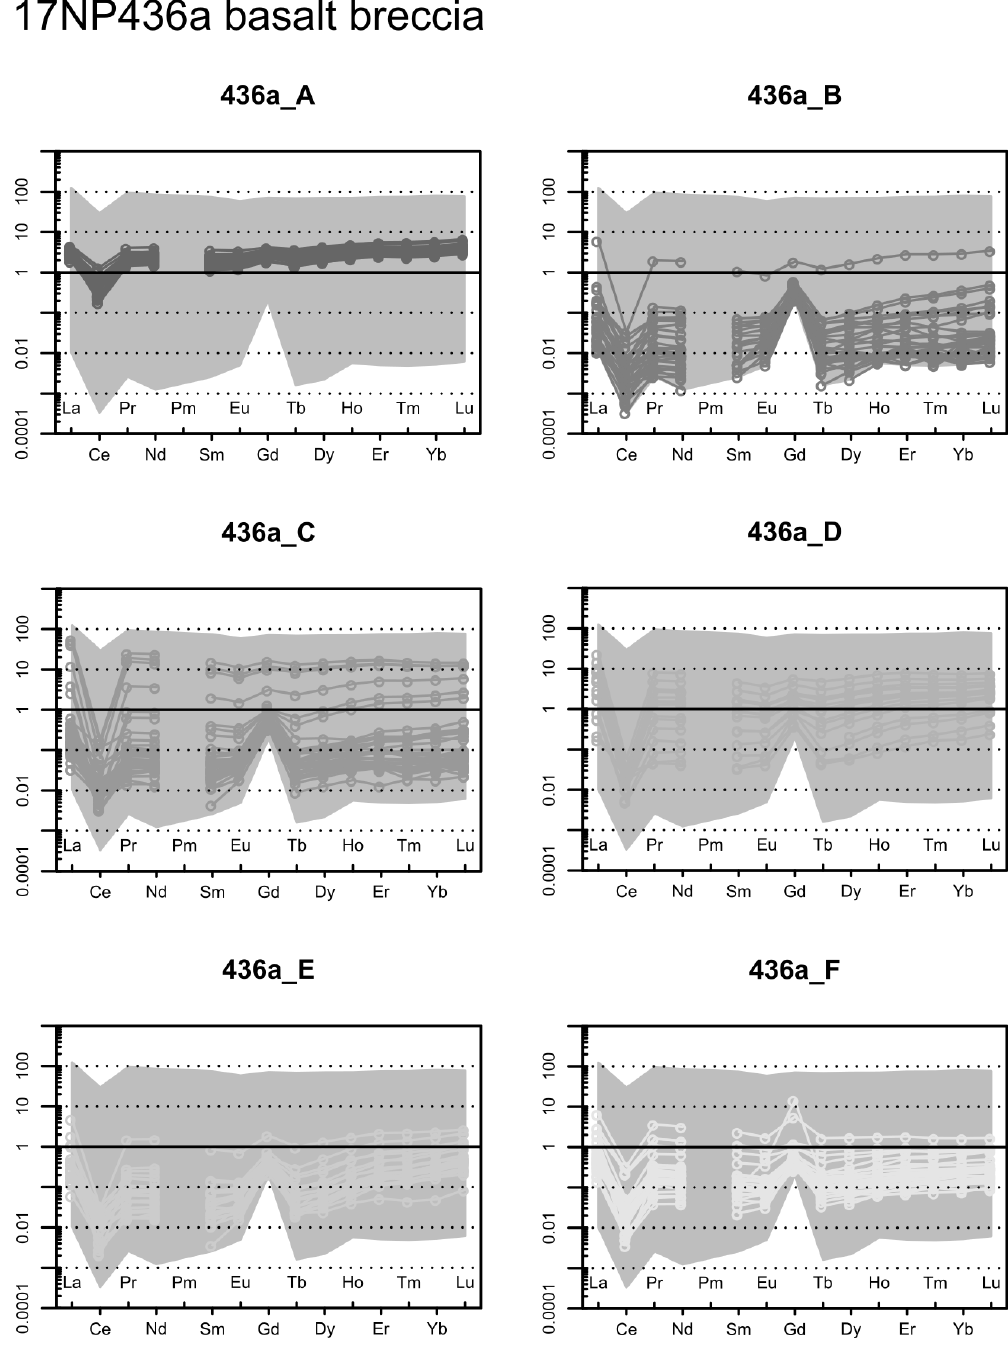
Figure C1. Rare earth element plots of each individual ablation area for sample 17NP436a. Grey shaded area in each diagram represents the range of chondrite-normalized REE concentrations in all calcite ablation